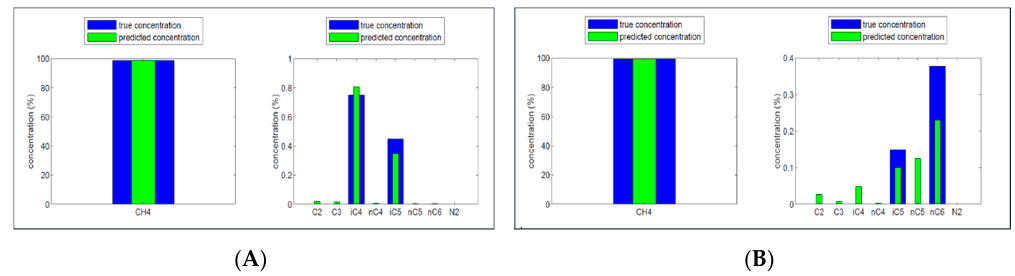
Figure 8. Concentration predictions for two gas mixtures containing ( A ) methane, iso-butane, and iso-pentane and ( B ) methane, iso-pentane, and n-hexane.